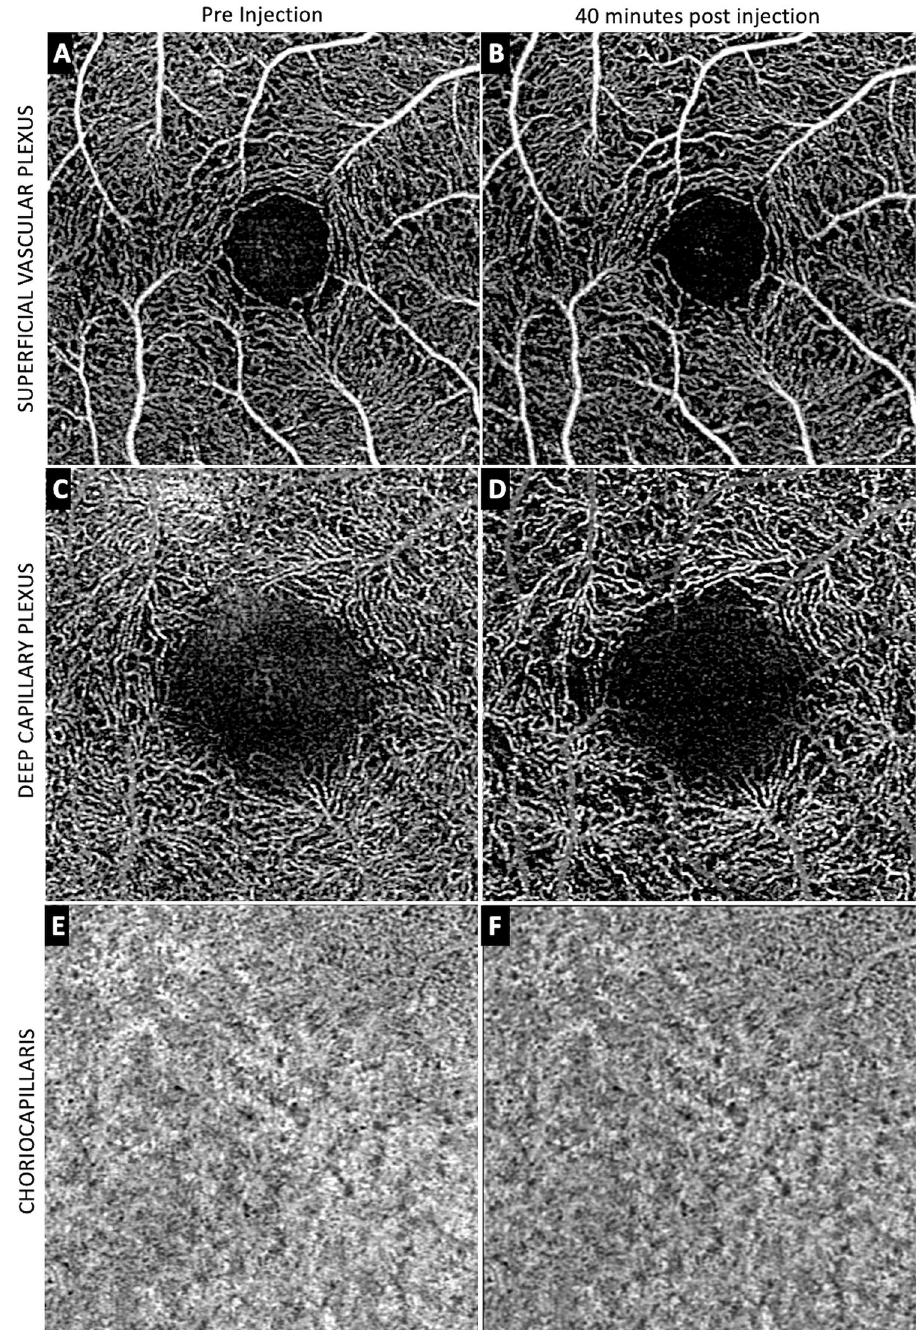
Figure 3. Averaged OCTA images of pre- and 40-min post-injection of each retina layer of Monkey 1. Panel ( A ), ( C ) and ( E ) showed the OCTA images of the superficial vascular plexus (SVP), deep capillary plexus (DCP) and choriocapillaris (CC) layers pre injection and the corresponding 40-min post-injection images ( B , D , F ). In the SVP, the 40-min post injection image ( B ) is very similar to the pre-injection image ( A ) with only subtle and minimal areas of flow deficit compared to pre-injection. In the CC layer, the 40-min post-injection image was also similar to the pre-injection image ( E , F ) suggesting almost complete recovery of perfusion. The DCP however, showed persistent areas of reduction in flow in the 40-min post injection image ( D ) compared to pre- injection ( C